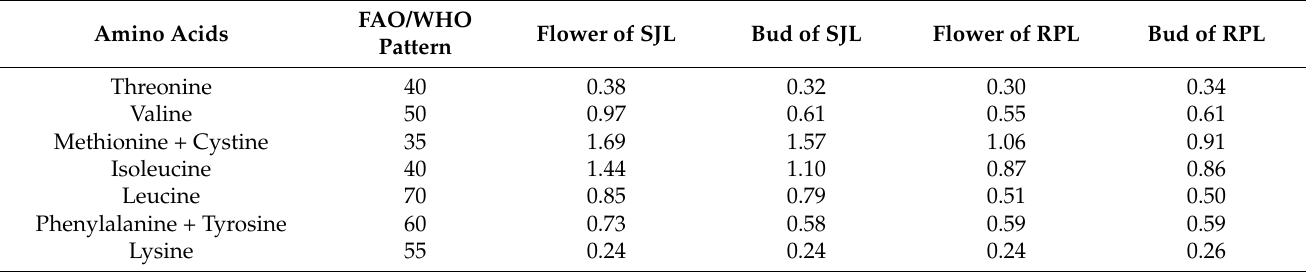
Table 4. Essential amino acid composition of compared to the FAO/WHO pattern. (mg/100 g protein dw).